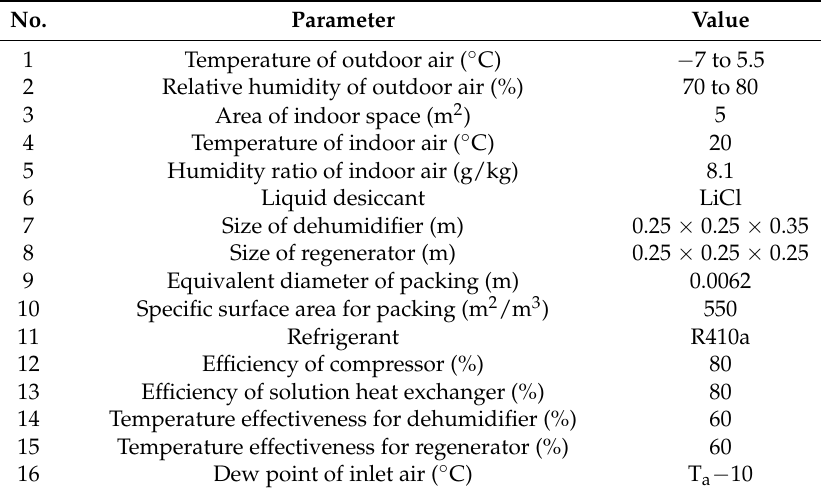
Table 6. Parameters of the analysis calculation